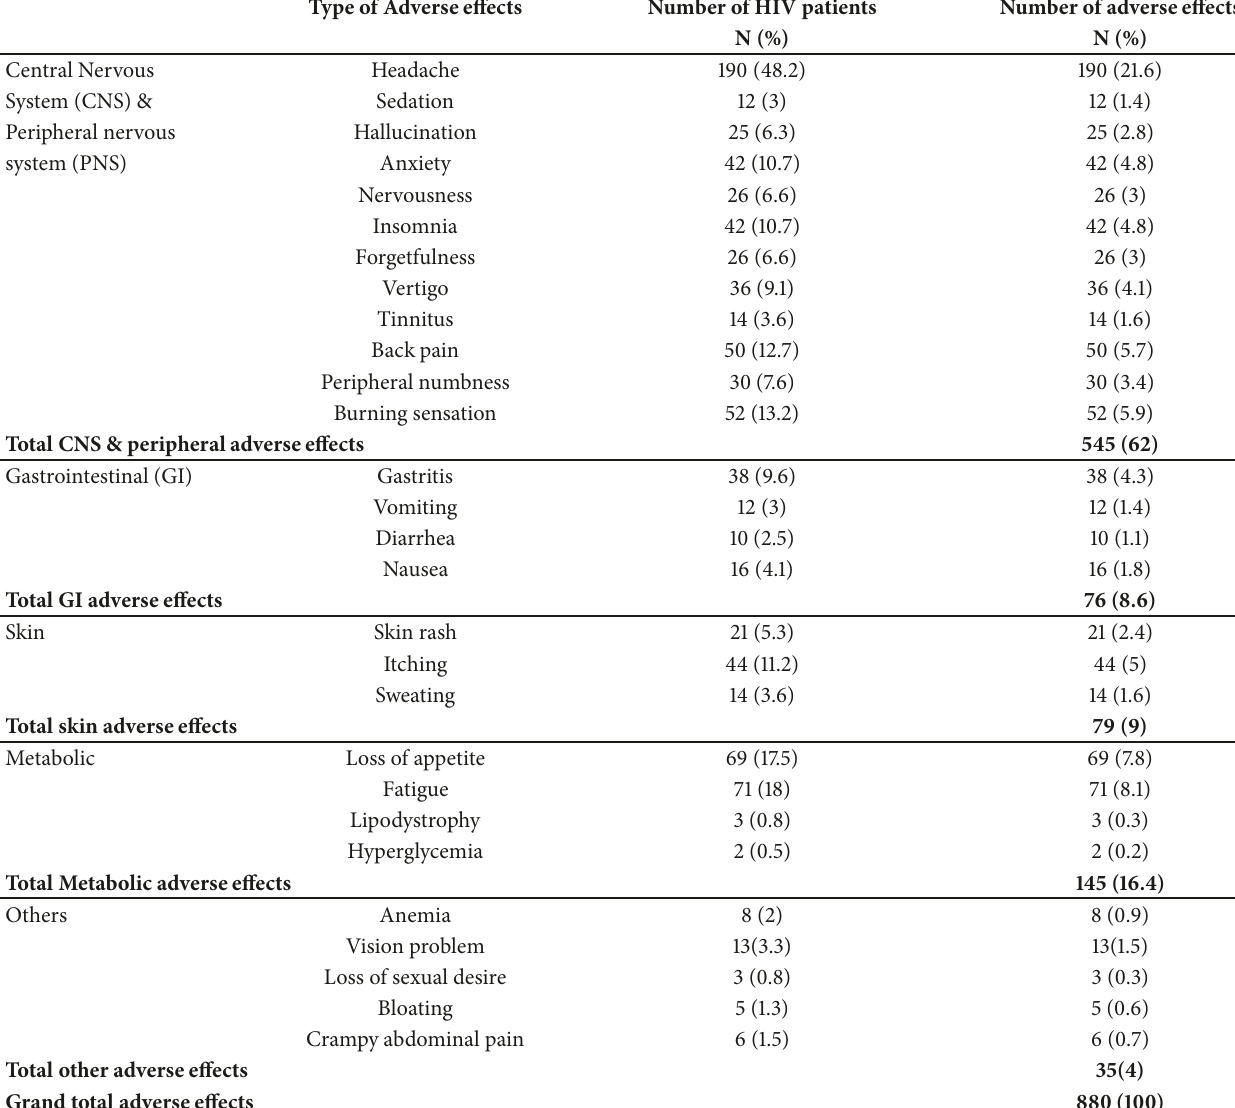
Table 4: Frequency distribution of adverse effects experienced by HIV patients who wereattending HIV clinic at